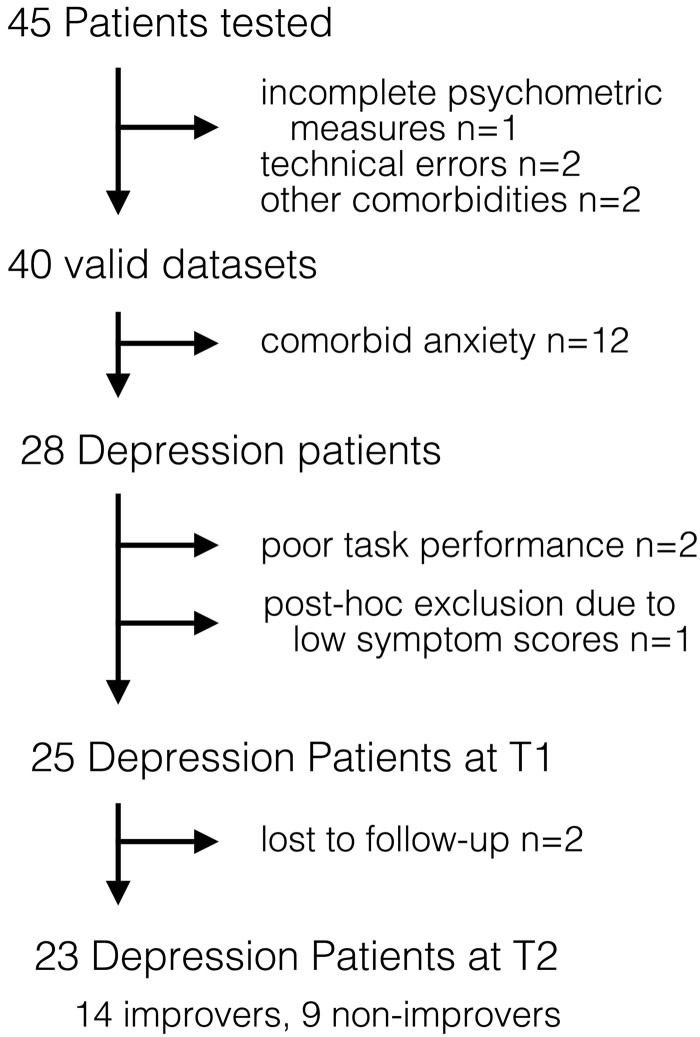
CONSORT (Consolidated Standards of Reporting Trials) diagram for patients in the
study. A total of 45 patients with major depressive disorder, dysthymia and/or
generalized anxiety disorder were recruited. Data were lost due to technical errors
(n = 2), incomplete psychometric measures
(n = 1) and due to co-morbidities identified in the Structured
Clinical Interview for DSM-IV-TR Axis I Disorders (SCID) after task completion
(n = 2), resulting in 40 valid datasets. Analyses focused on
patients with depression only.